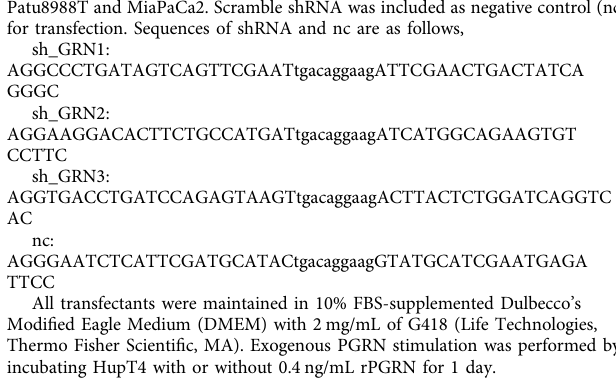
Fig. 7 In vitro PGRN blockade promotes CD8 antitumor cytotoxicity via MHCI regulation. a Genetic strategy to induce spatially and temporally controlled GP33 expression by tamoxifen-mediated activation of CreERT2 in pancreatic cells harboring mutant Kras G12D and loss of Tp53 . Ptf1a wt/ fl p ; Kras wt/FSF-G12D ; p53 frt/frt (FKP) mice crossed to Gt(ROSA)26Sor tm3(CAG-Cre/ERT2)Das ( R26 FSF-CAG − CreERT2 ) and Gt(ROSA)26Sor tmloxP-STOP-loxP-GP-IRES-YFP ( R26 LSL-GP ) strains to generate FKPC2GP mice. b Experimental setup for co-culture of GP82, LCMV-gp33-expressing cell line derived from FKPC2GP tumor, and the